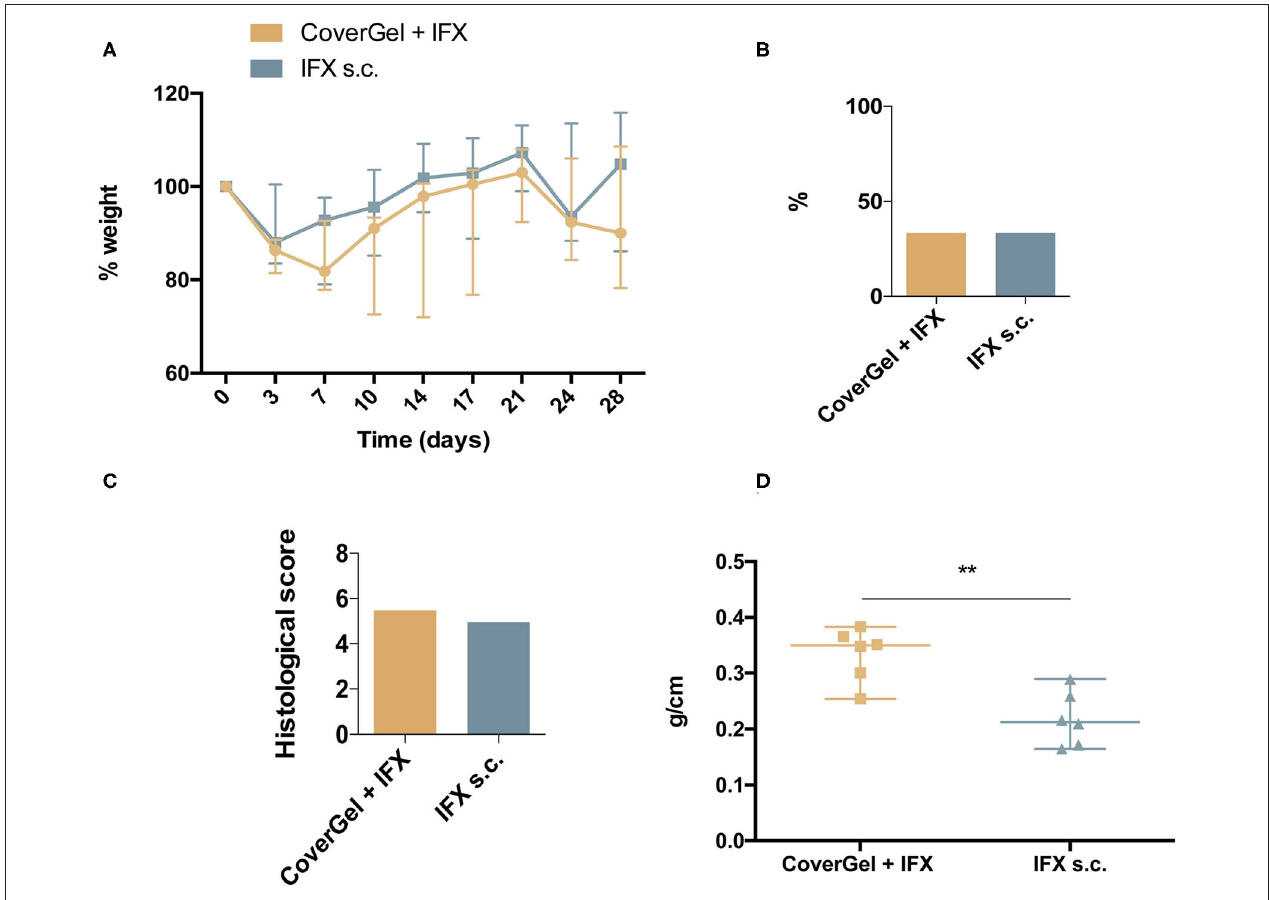
FIGURE 8 | Clinical evaluations on rats from the acute EC animal model. Color representations are as follow: CoverGel + IFX group and